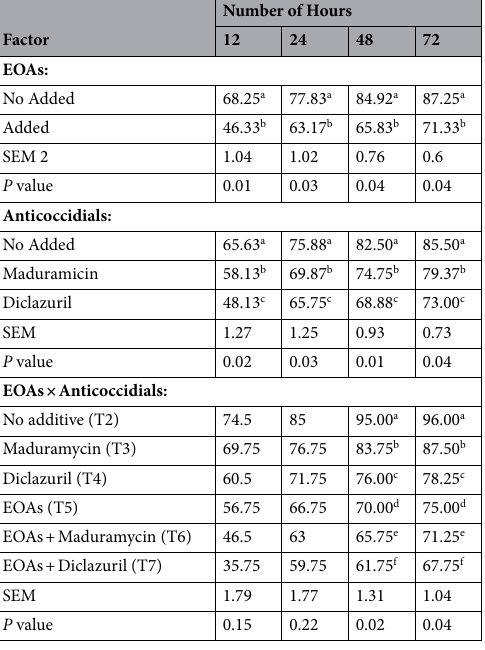
Table 4. In vitro anticoccidial effect of EOAs and anticoccidials on the SP 1 in infected broilers. a–b In each column, means with no same (a, b) superscript differ significantly in p < 0.05 value. 1 SP: Sporulation percentage of Eimeria oocysts. 2 Pooled standard error of mean.